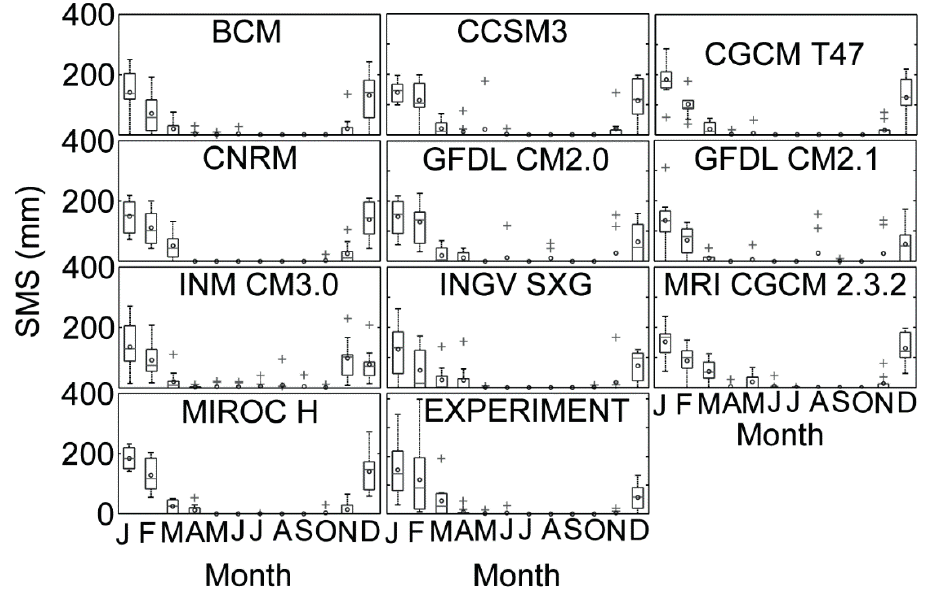
Fig. 3 Experimental and GCMs’ monthly SMS for sugar cane